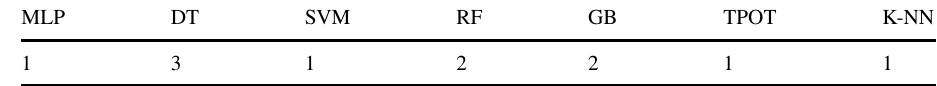
real-time voting